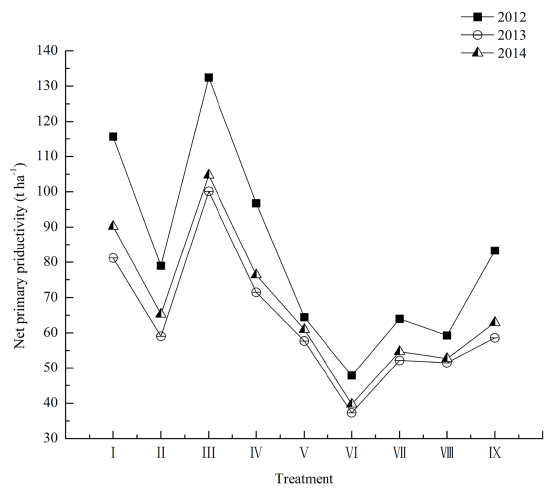
Figure 2. Dynamics of net primary productivity of living trees.